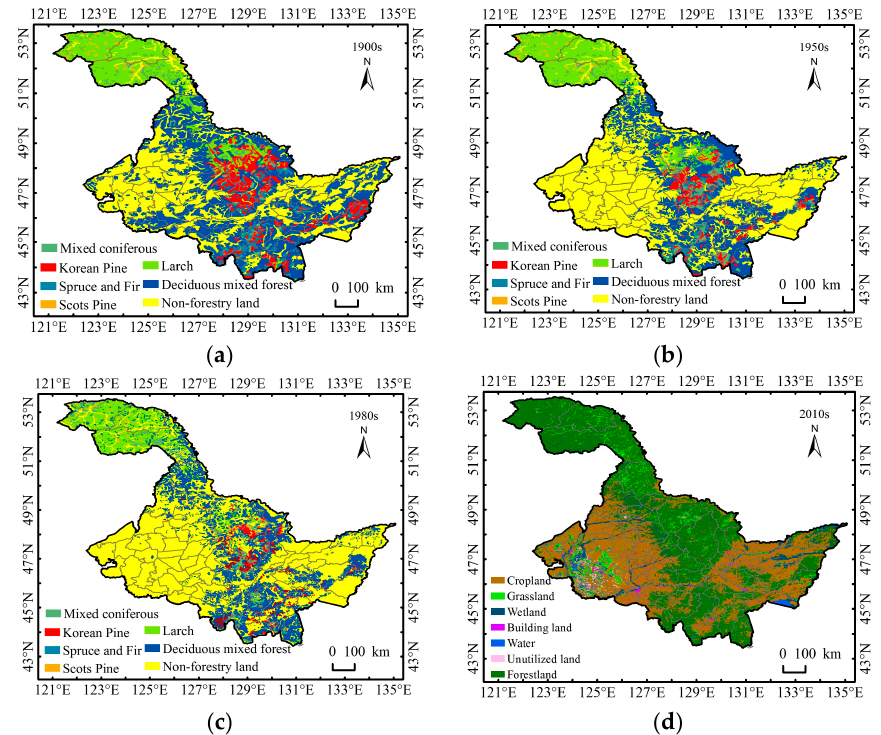
Figure 2. Maps to show the spatial distribution of forests within Heilongjiang Province between the 1900s and 2010s. ( a ) 1900s; ( b ) 1950s; ( c ) 1980s; ( d ) 2010s.